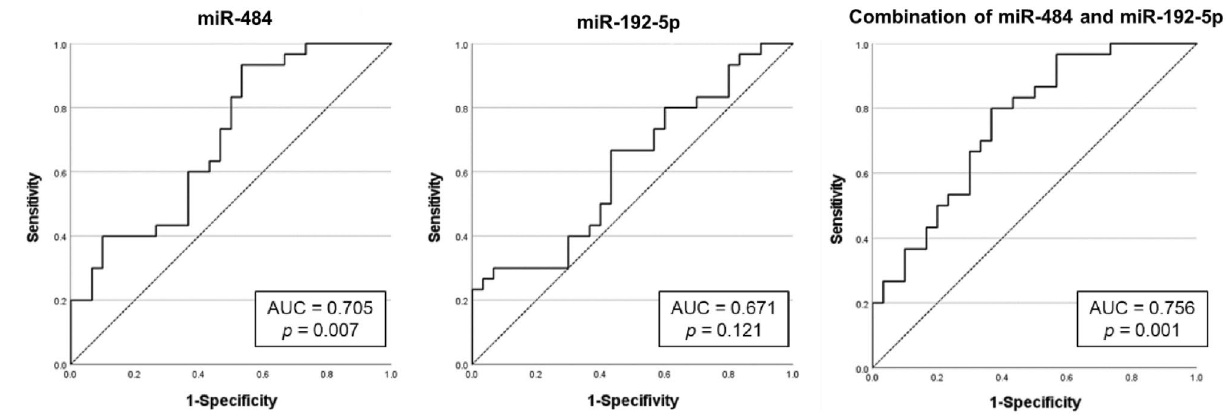
Figure 3. The receiver operating characteristic curve analysis of miR-484, miR-192-5p, and the combination of these two miRNAs to classify patients with active and inactive thyroid eye